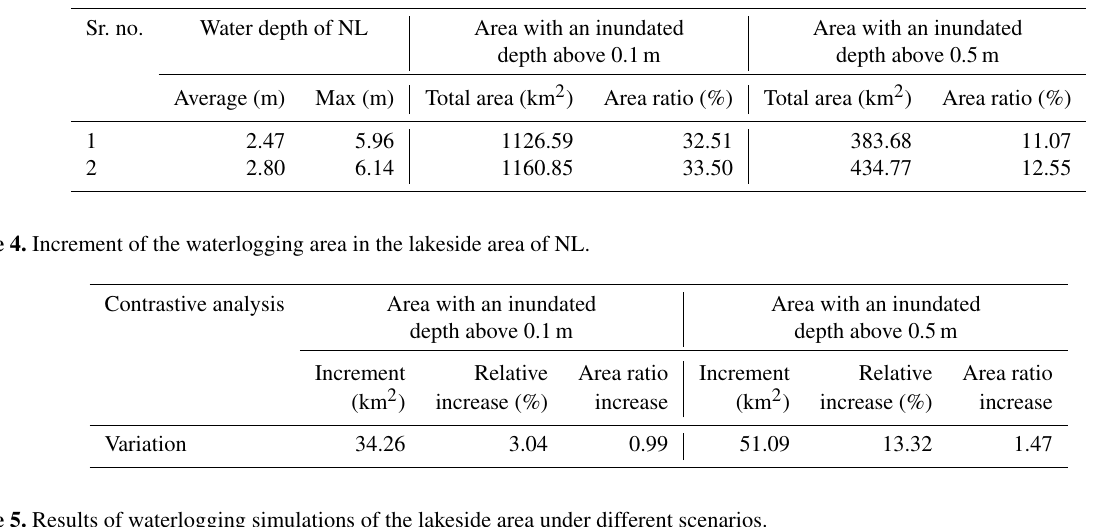
Table 5. Results of waterlogging simulations of the lakeside area under different scenarios. Sr.